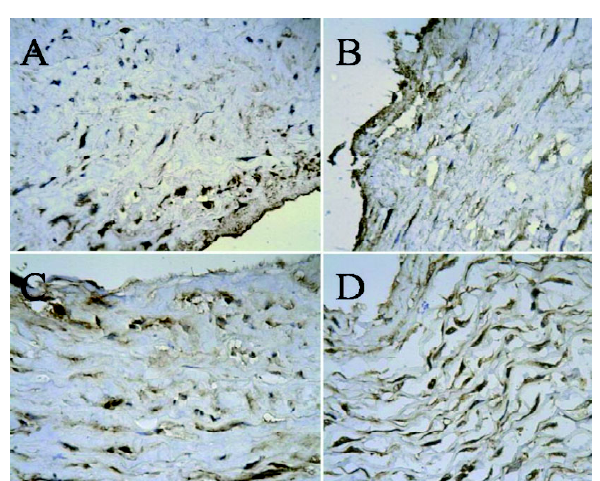
Fig. 11 - In the adventitia, the expressions of osteopontin was positive in the aortic dissection (A), coronary artery disease (C) and healthy control (D) groups, while it was weak positive in the aortic aneurysm (B) group.